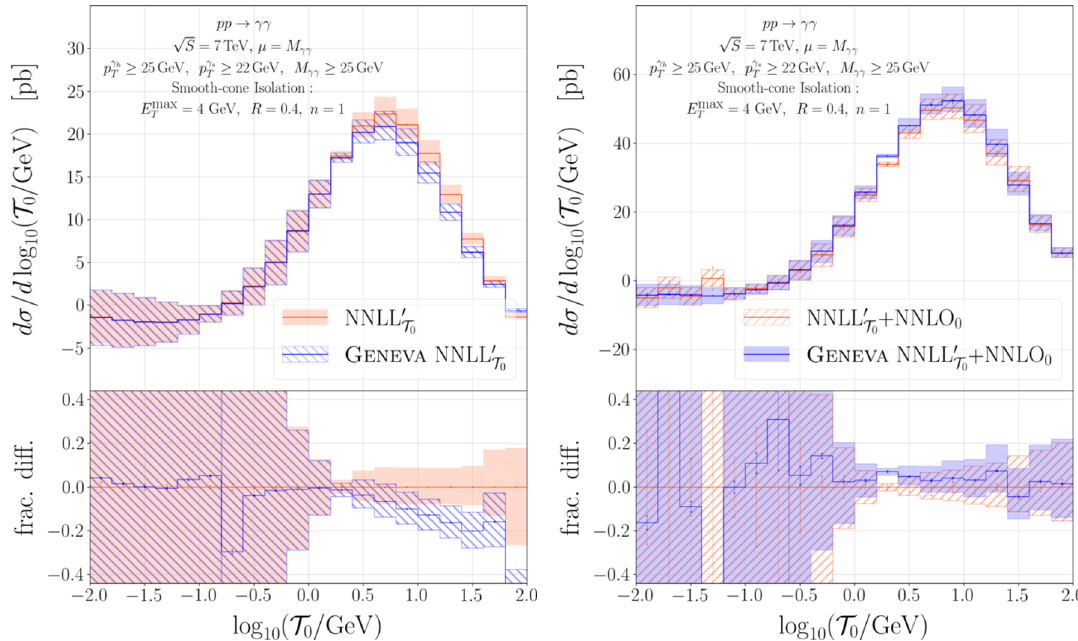
Figure 2 . Comparison between standard resummation and event generation in Geneva in the presence of projection cuts. We show the resummed contribution alone (left) and the result matched to NNLO